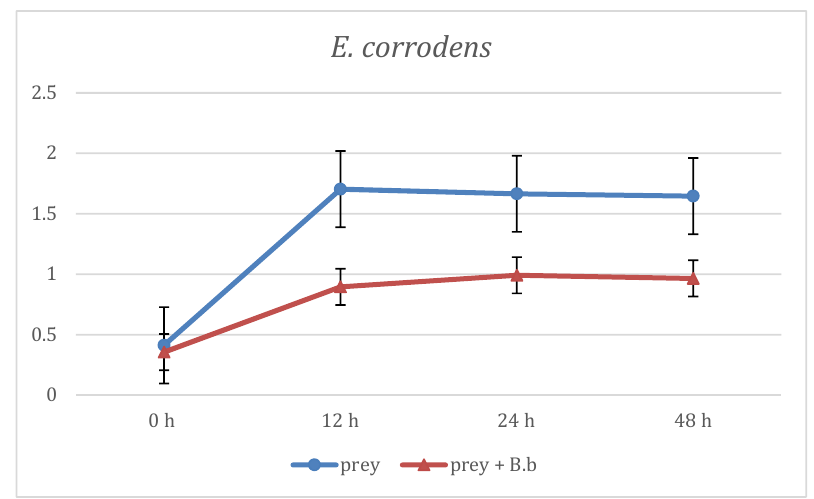
Figure 2. Predation activity of B. bacteriovorus against E. corrodens .